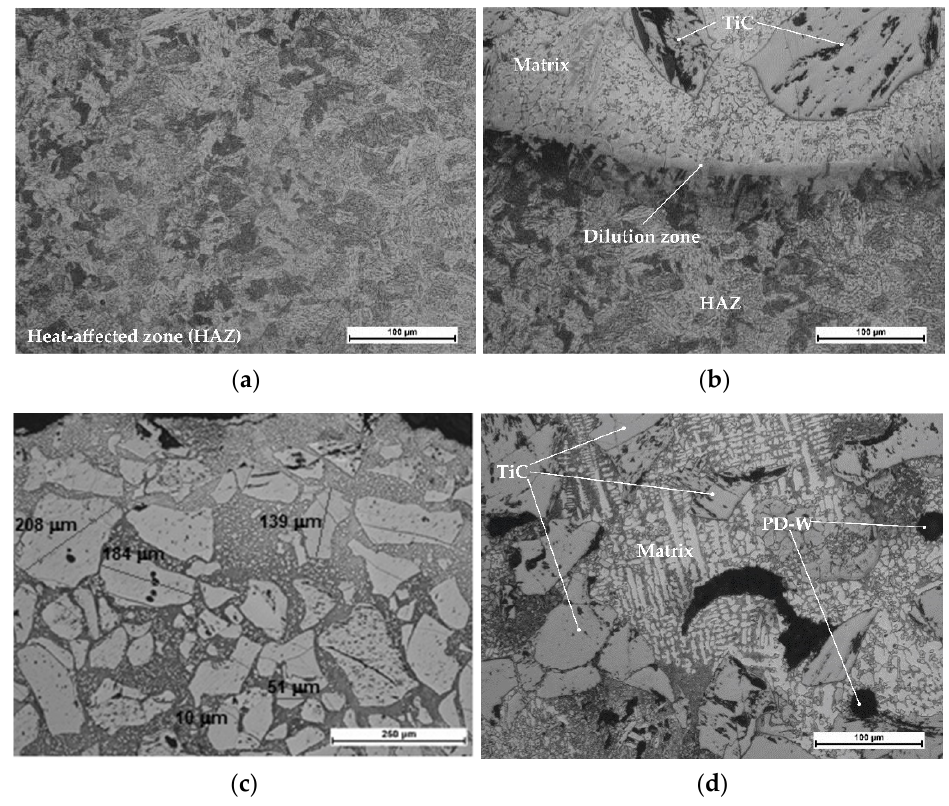
Figure 10. Microstructure of the surface layer (PPTAW metal deposition method, Co3+TiC+PD-W composite powder) deposited on structural low-alloy steel AISI 4715: ( a ) heat affected zone (HAZ), ( b ) dilution zone, ( c ) size and distribution of the hard phase in the middle of the cladding and ( d ) structure of the matrix of the solid solution near the padding weld.